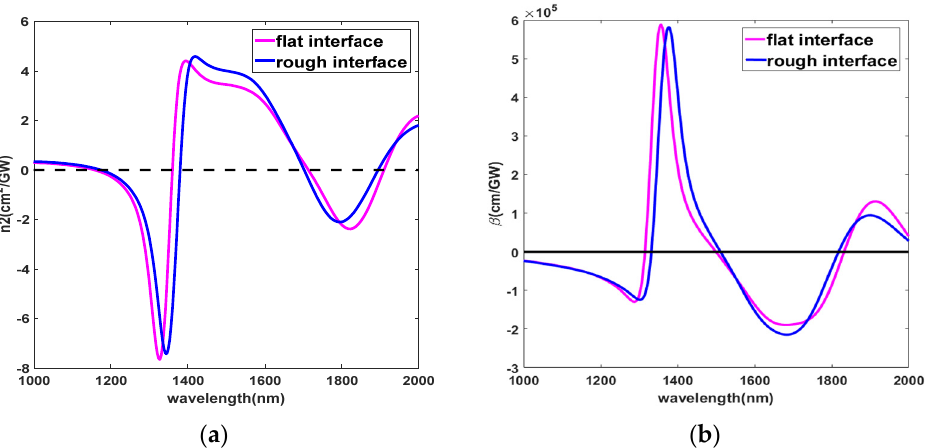
Figure 6. Nonlinear coefficient of flat and rough interfaces: ( a ) Effective nonlinear refractive index n 2 in x and y polarization, ( b ) Nonlinear absorption coefficient 𝛽 in x and y polarization